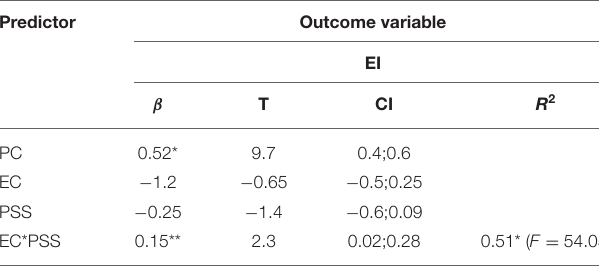
TABLE 3 | Moderated mediation effect of PSS using process macro.